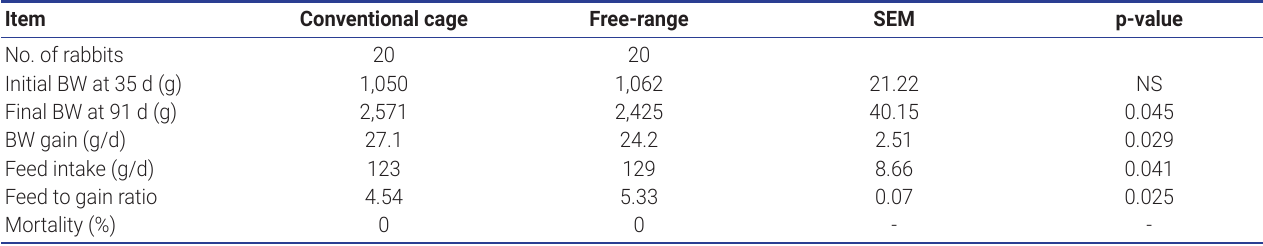
Table 2. Effect of rearing system on growth performance of rabbits Item Conventional cage